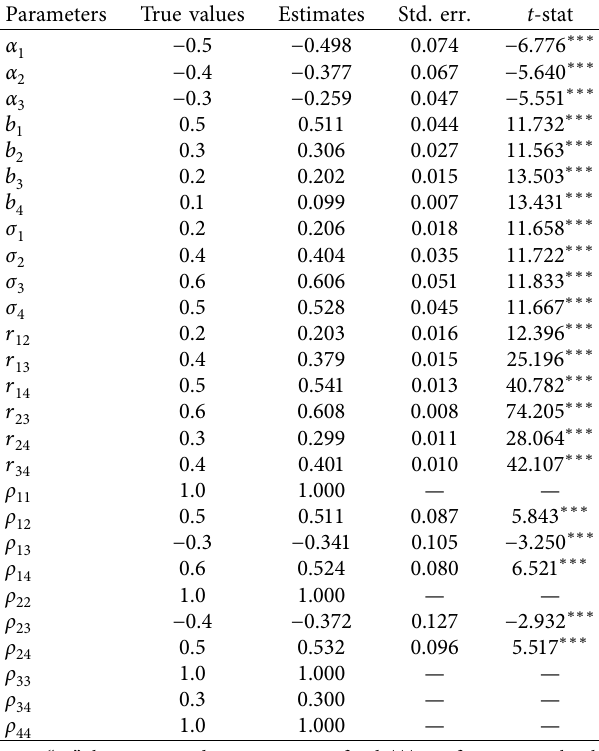
Table 1: Simulation results for a four-alternative MMNP model of 500,000 observations when random coefficients are associated with generic variables.